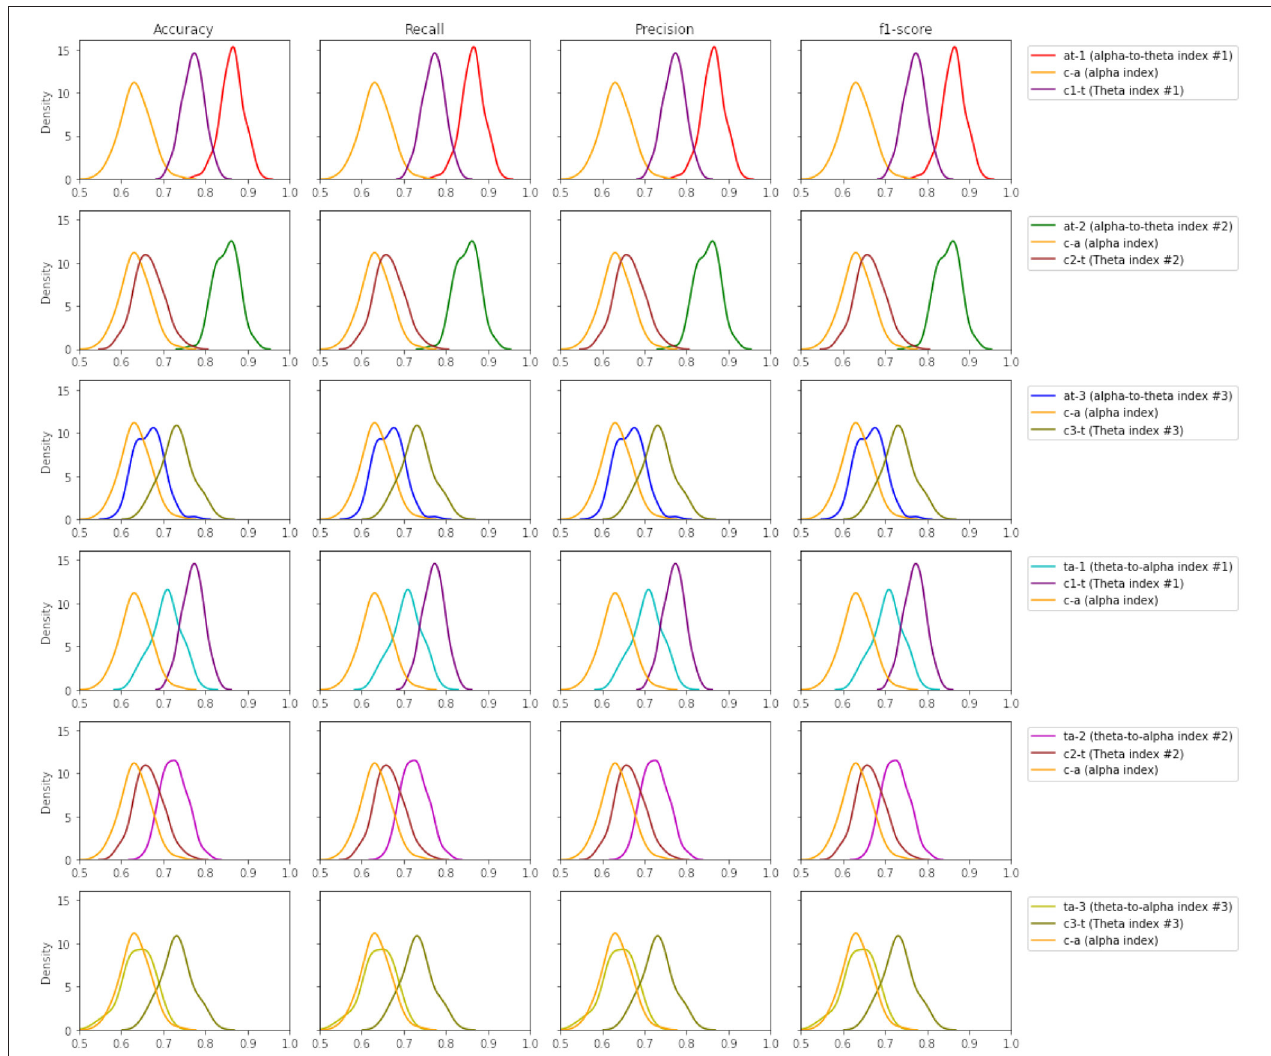
FIGURE 7 | Density plots for SVM across all performance metrics between band ratio indexes vs. their individual indexes. at − 1, at − 2 and ta − 1, ta − 2 can better discriminate